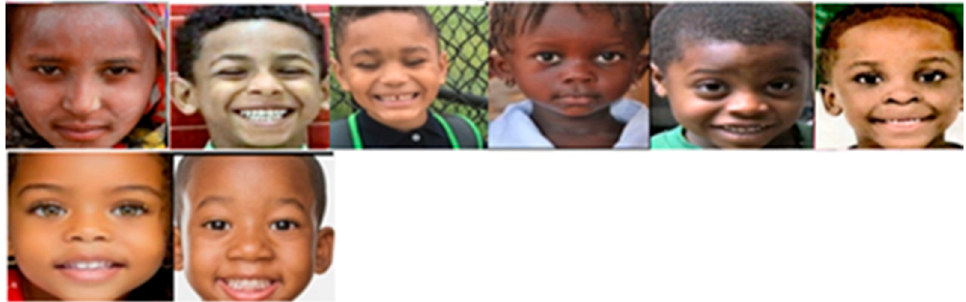
Figure 8. Six (top row in the figure) out of the eight TD Black children’s images in the Kaggle test dataset were misclassified as Autism .